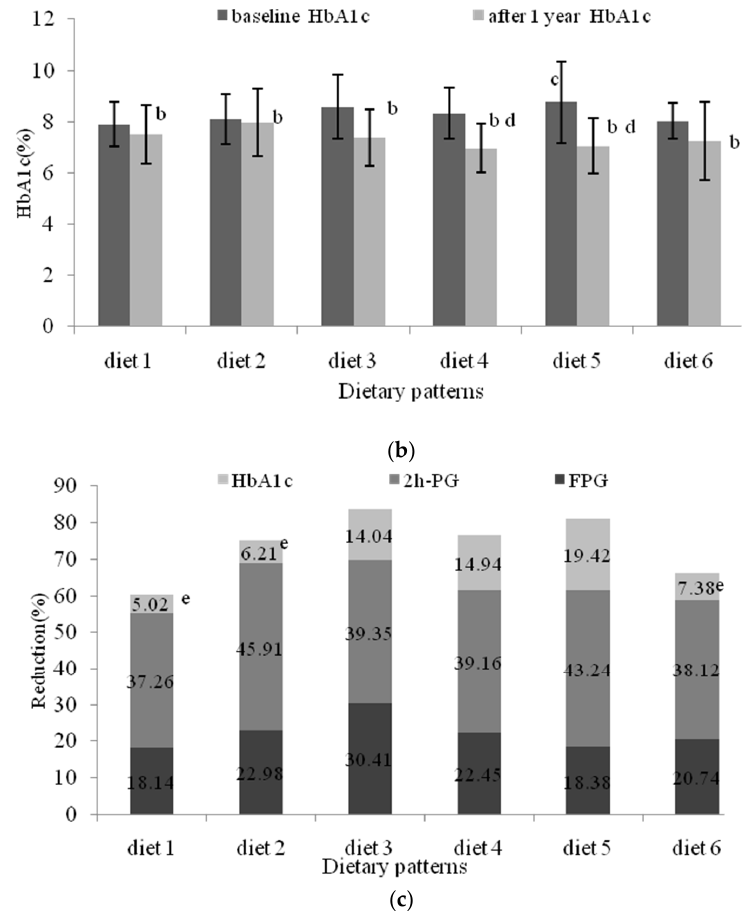
Figure 3. The 2 h ‐ PG and FPG of participants selected different dietary patterns. ( a ) the 2 h ‐ PG and FPG value; ( b ) HbA1c value; ( c ) the reduction of FPG, 2 h ‐ PG and HbA1c. Diet 1, Traditional diet; Diet 2, Vegetarian diet; Diet 3, Japanese diet; Diet 4, Low energy diet; Diet 5, Healthy diet; Diet 6, Monotonous diet. The results were expressed as mean (standard deviation). a compared with PG value at baseline ( p < 0.05); b compared with HbA1c value at baseline ( p < 0.05); c HbA1c value at the baseline compared with the diet 1 ( p < 0.05); d HbA1c value after 1 year was compared with the diet 2 ( p < 0.05); e HbA1c value reduction was compared with the diet 5 ( p < 0.05); * compared with 2 h ‐ PG value of diet 1 at the baseline ( p < 0.05).